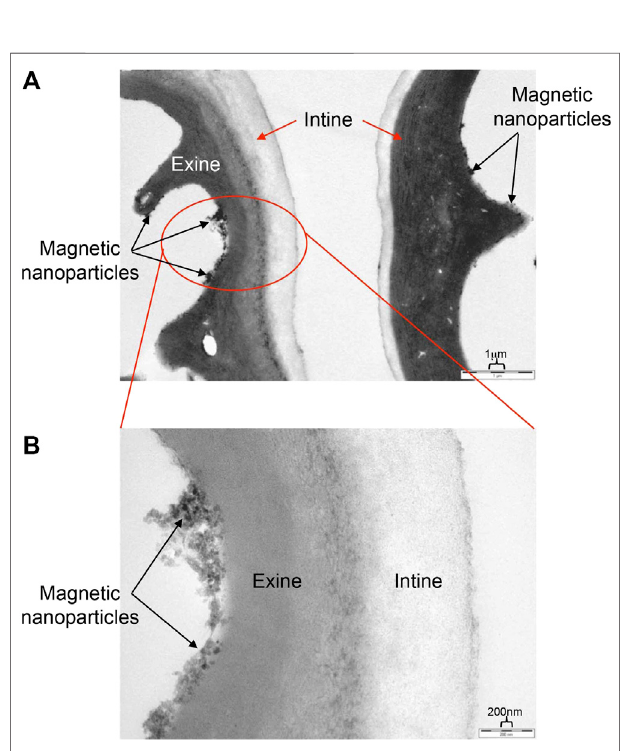
FIGURE 6 | TEM images of an exine-intine wall of a MS1 particle. The upper picture (A) shows a slightly fl attened MS1 particle; and the bottom picture (B) shows a close up for the red circular area of the top picture. The scale bar for the top image is 1 µm and for the lower 200 nm.